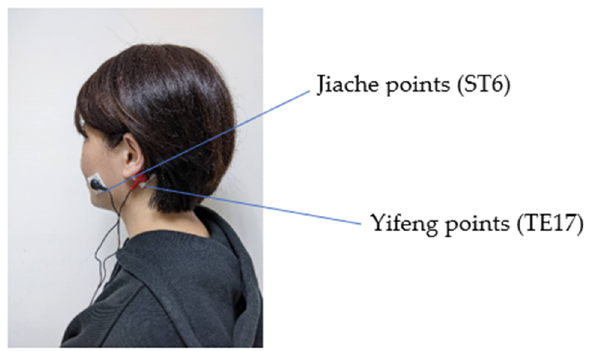
Figure 1. The TEAS used in the present study .